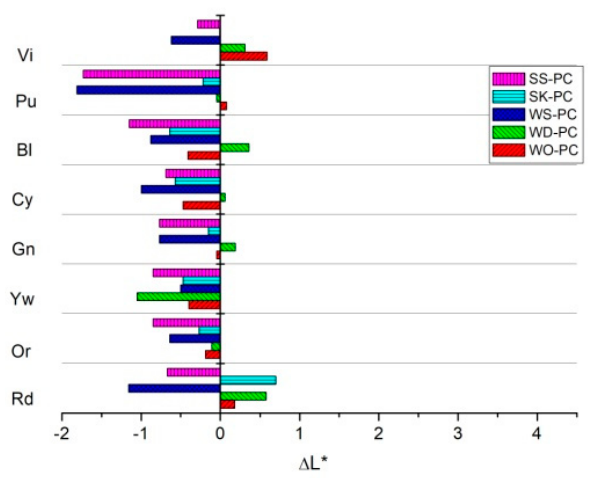
Figure 2. Δ L* calculated using PC adjustment as the target and other adjustment conditions as samples.